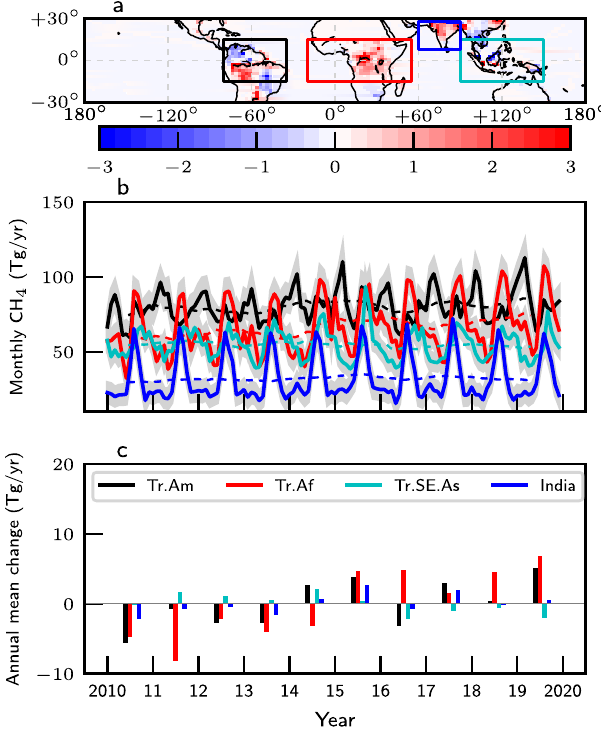
Fig. 2 Changes in tropical CH 4 emissions. a The 2015 – 2019 annual means minus the 2010 – 2014 annual means of a posteriori tropical CH 4 emissions (Tg/year); b corresponding monthly CH 4 fl uxes from tropical South America (black line), tropical Africa (red line), India (blue line), and tropical maritime Southeast Asia (cyan line); c corresponding annual mean a posteriori CH 4 fl uxes relative to their 10-year (2010 – 2019) means. Shaded envelopes in ( b ) denote the 1 – σ uncertainty. Dashed lines in ( b ) denote the 2010 – 2019 12-month rolling mean values for each